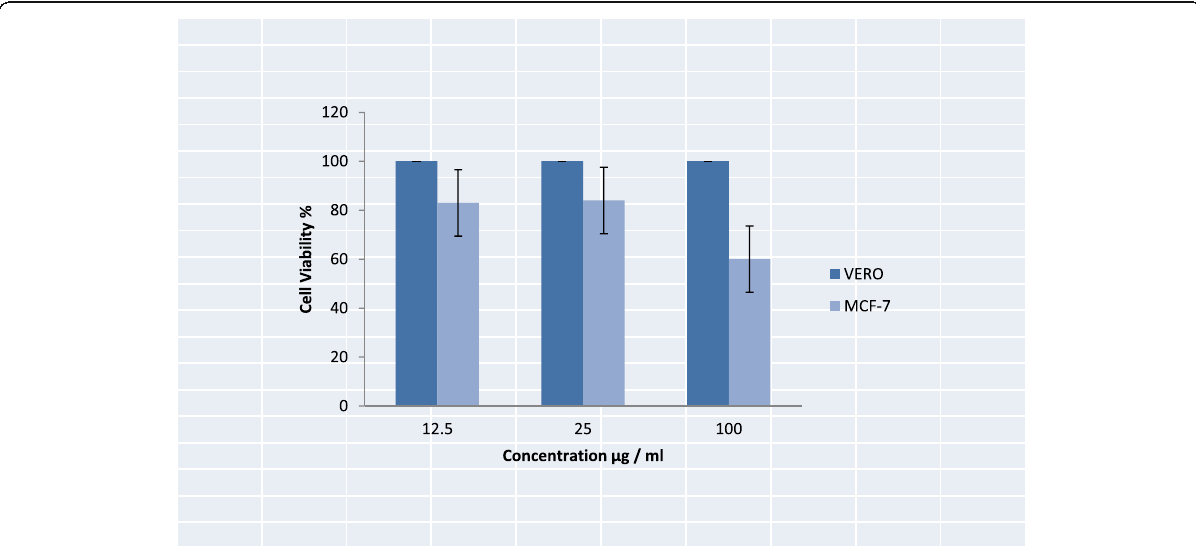
Fig. 1 Cytotoxicity of Ag NPs. Effect of AgNPs on viability of MCF7 and Vero cell lines. Cells were seeded at 37 °C for 24 h prior to treatment with AgNPs. Cells were either treated with (12.5, 25, 100 μ g/ml) of AgNPs for 48 h or treated with DMSO only as control. Cell viability was measured with MTT